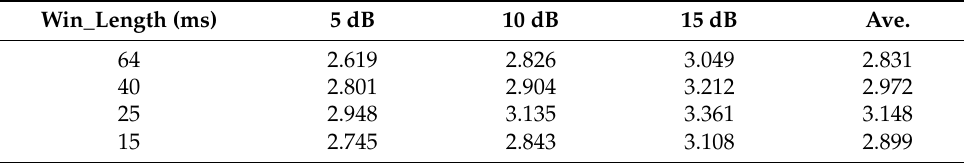
Table 3. The PESQ scores for models with different window lengths.